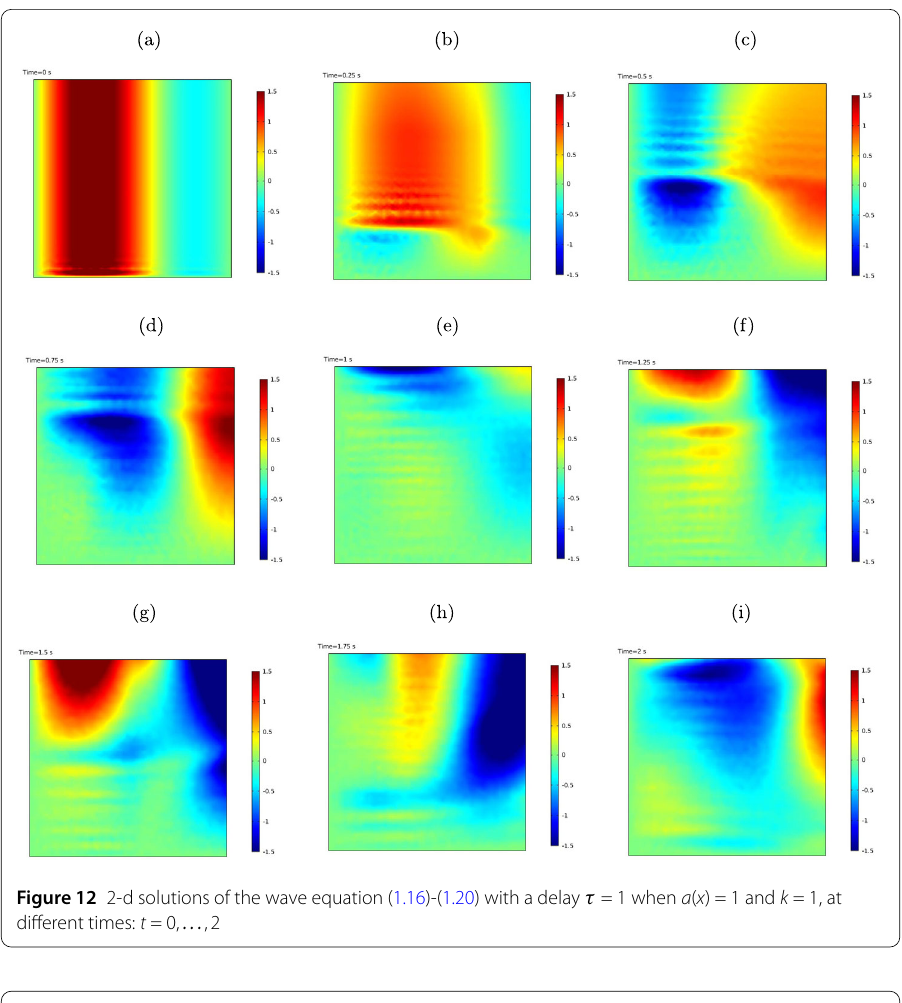
Figure 13 The energy E ( t ) of the system (1.16)-(1.20) with a delay τ = 1 when a ( x ) = 1, and k = 1